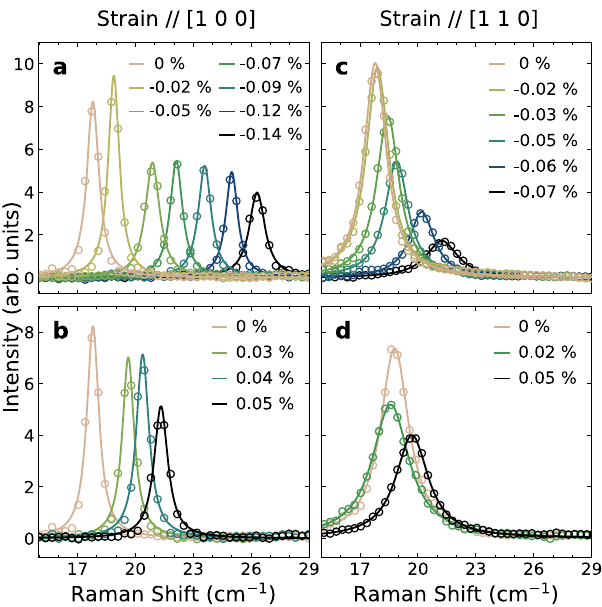
Fig. 2 | Raman spectra of single-magnon excitations under uniaxial strain. Background-subtracted low-energy Raman spectra were measured under a compressive and b tensile strain along the [1 0 0] direction and under c compressive and d tensile strain along the [1 1 0] direction. Solid lines are the results of Lorentzian fi ts to the